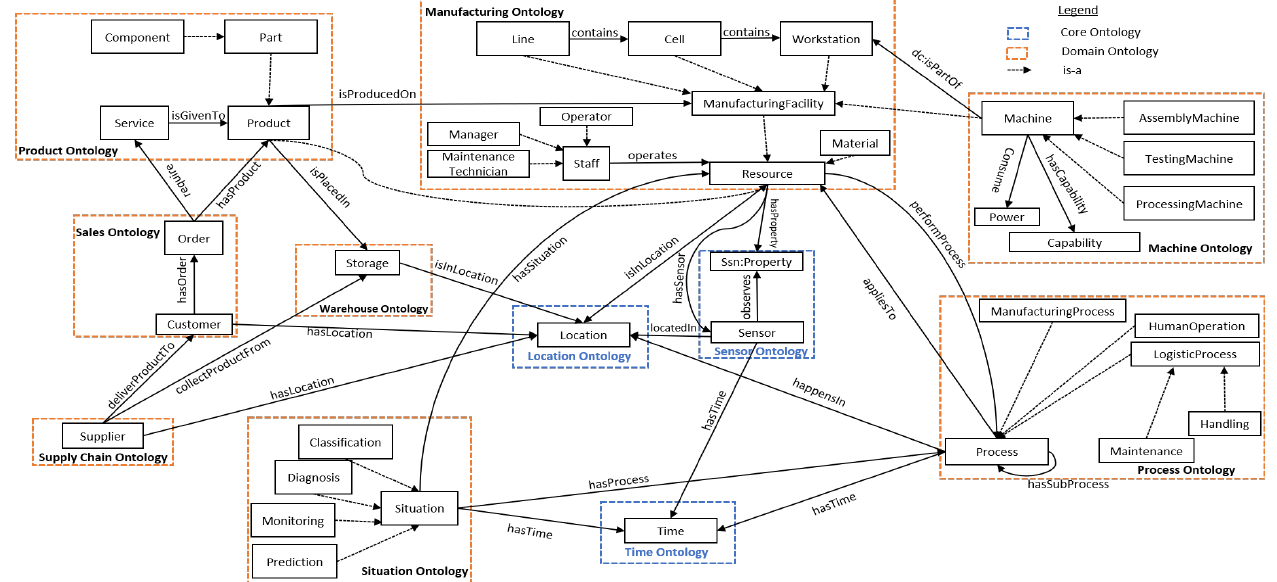
Figure 5. High level representation of Reference generalized ontological